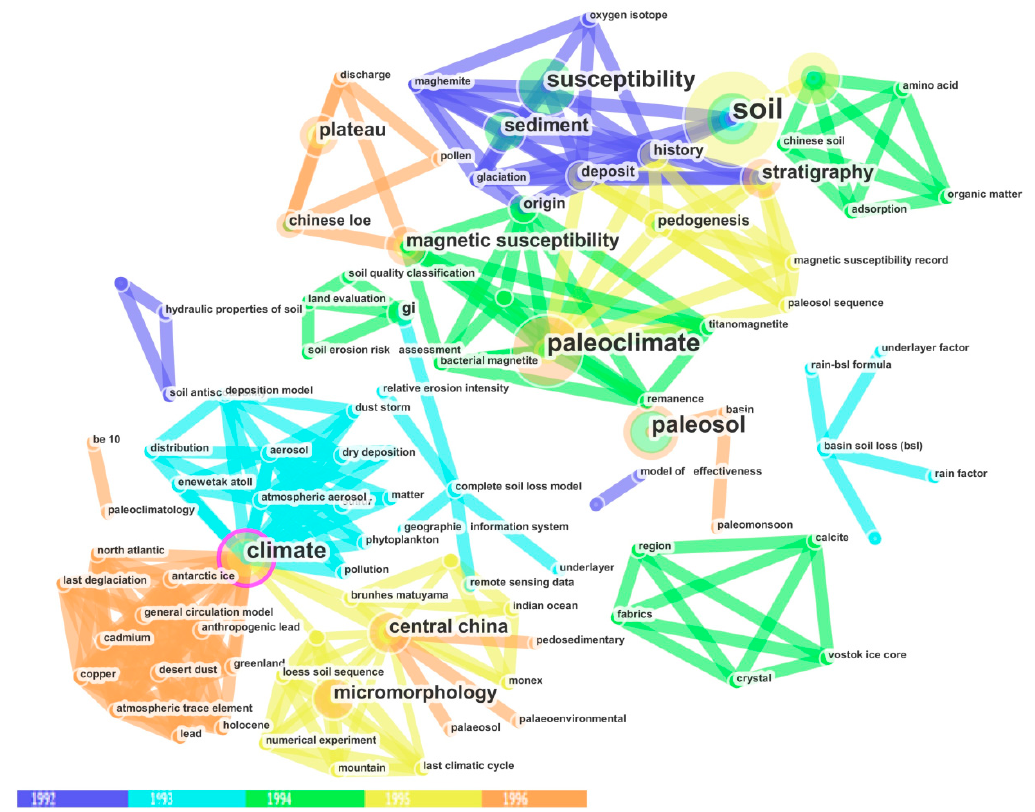
Figure 2. The bibliometric network map of keywords based on Science Citation Index (SCI) literature from 1992–1996. Table 1 ． Annual distribution of the main research topics of Chinese National Knowledge Infrastructure (CNKI) literature from 1987–1996.